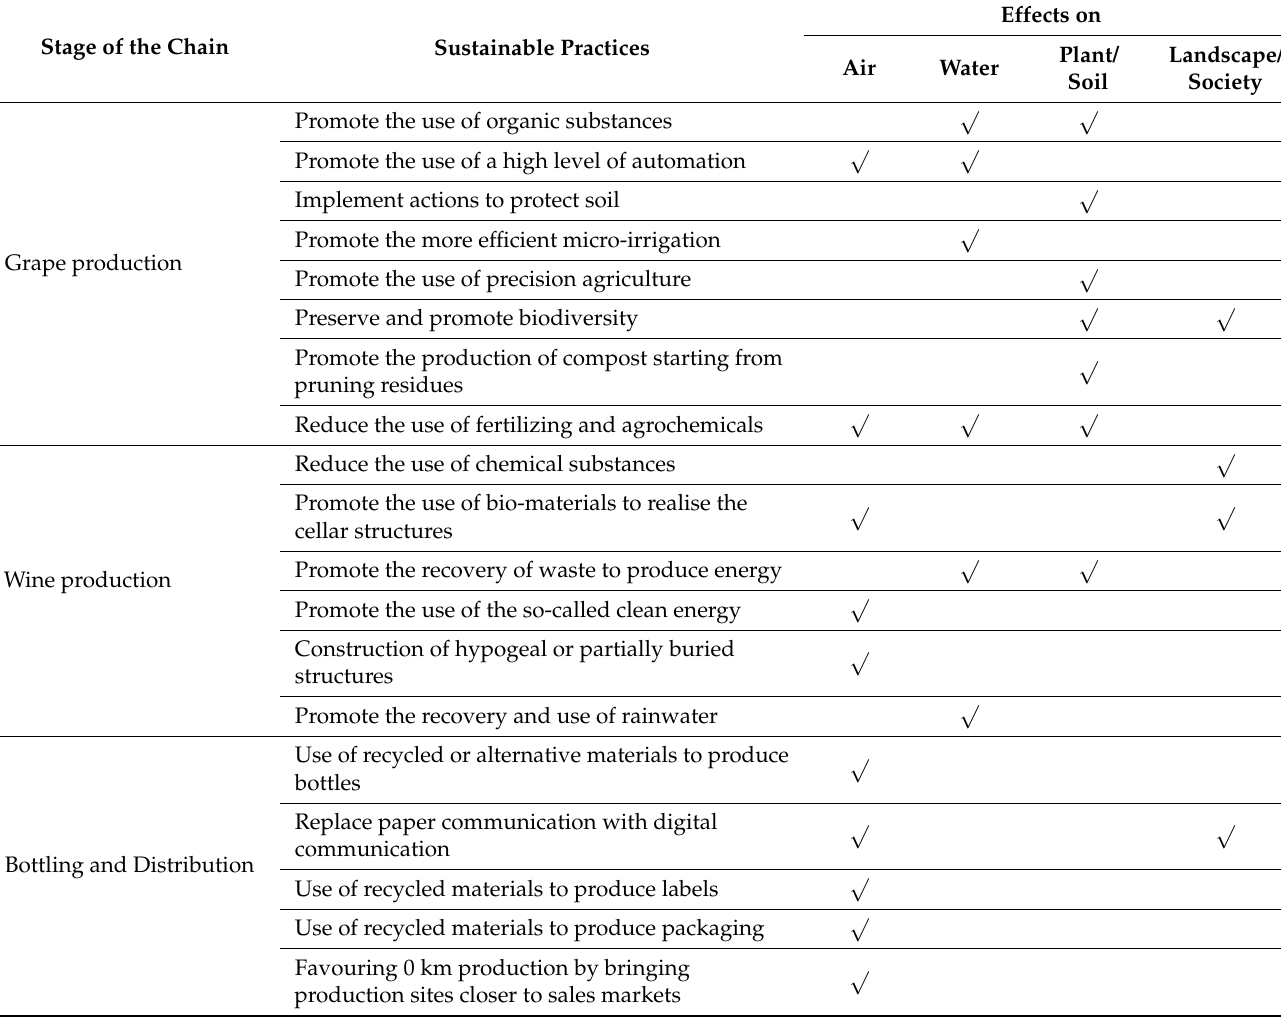
Table 2. Environmental practices in the wine sector (adapted from Bandinelli et al. [69]). Stage of the Chain Sustainable Practices